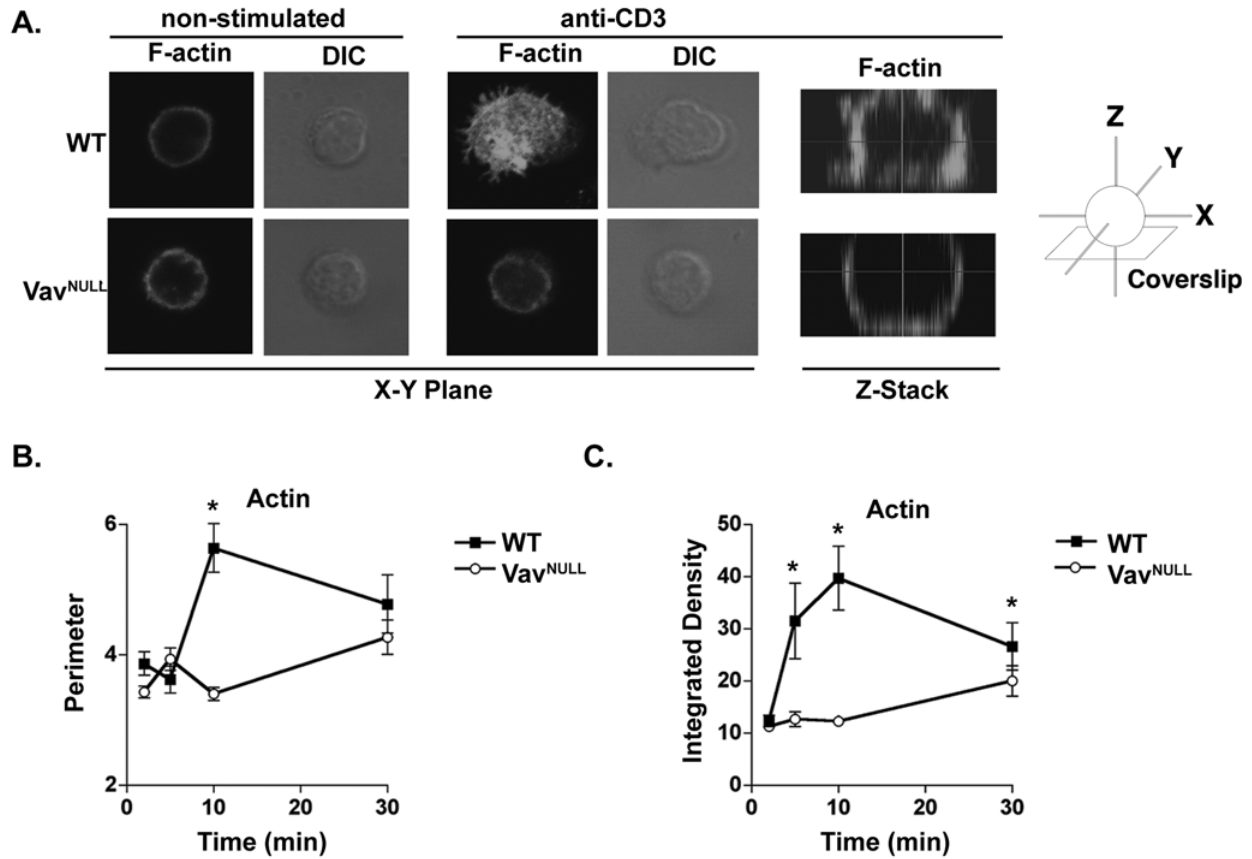
Figure 1. Vav NULL T cells show defective TCR-induced actin cytoskeletal reorganization and cell spreading. (A) Staining of F-actin with Alexa-Fluor-488-phalloidin in WT or Vav NULL T cells stimulated on anti-CD3-coated coverslips and fixed after 10 minutes. Shown are representative images of n $ 10 cells. Optical slices in the XY plane depict the cell-coverslip interface, and Z-stacked images depict the entire cell in the XZ plane. (B) Cell perimeter was measured in arbitrary units at the membrane-coverslip interface for T cells stimulated as in (A), data are mean 6 SD of n $ 10 images/time point. (C) The relative concentration of F-actin at the membrane-coverslip contact site measured as integrated density (pixel intensity) in arbitrary units of Alexa-Fluor-488-phalloidin fluorescence within the perimeter of the membrane-coverslip contact site described in (B). Asterisks (*) indicate p , 0.05.